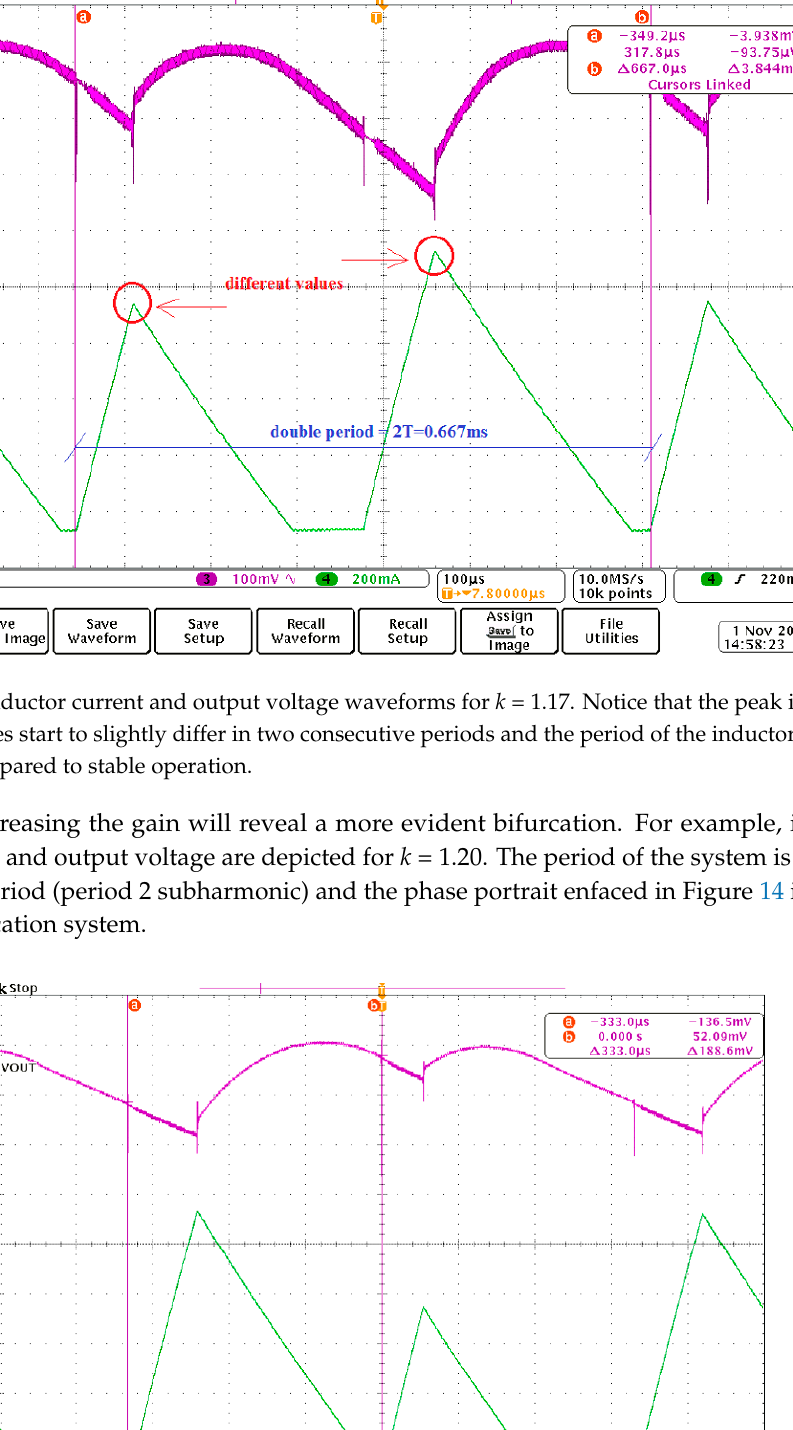
Figure 11. Phase portrait for k = 1.08, confirming stable operation.